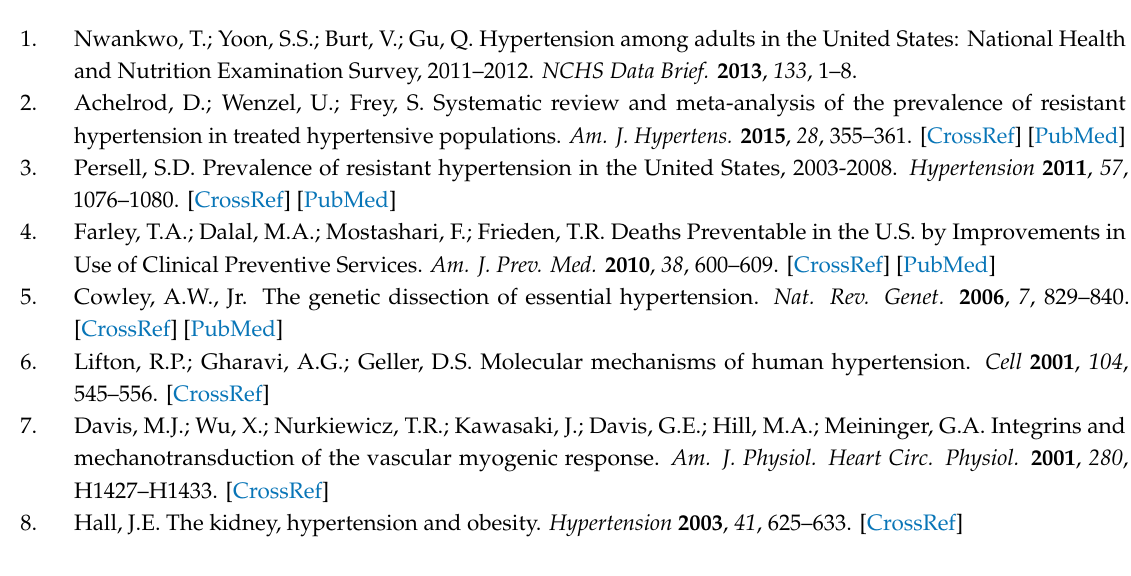
Figure S1: SMC-specific GRAF3 RQ expression had insignificant impact on diastolic BP, MAP or HR, Figure S2: Y792 is not a major Src or FAK phosphorylation site, Video S1: Predicted structure of the open (active) GRAF3 BAR-PH-GAP